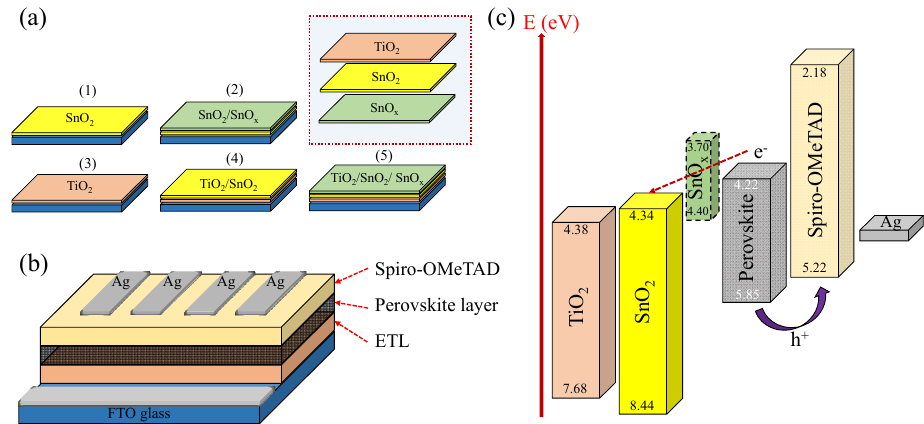
Figure 1. Schematic diagram of: ( a ) modified sequential thickness of ETL, ( b ) structure, and ( c ) energy band diagram of n-i-p perovskite solar cell.